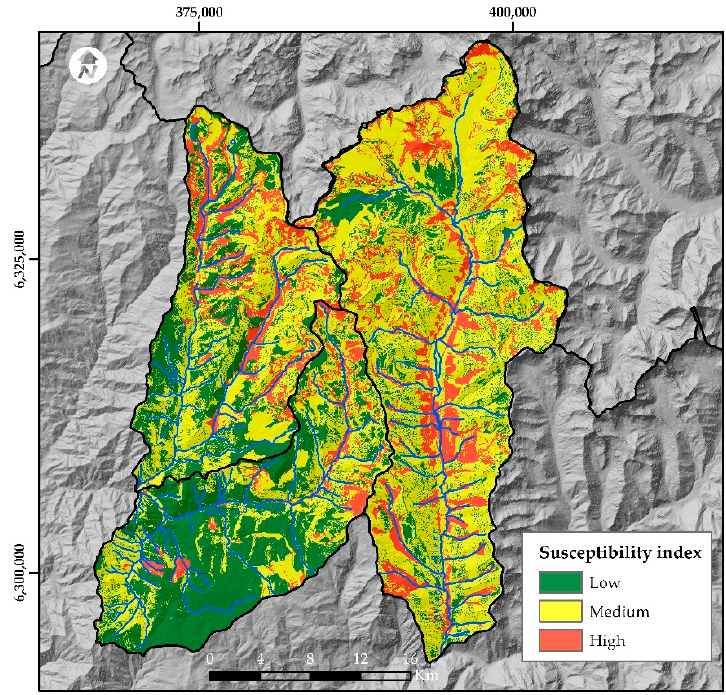
Figure 2. Susceptibility map to landslide in the upper sector of the Mapocho river